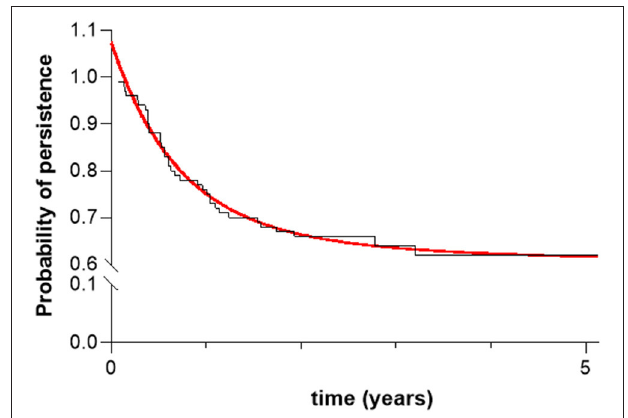
FIGURE 1 | Survival curve of secukinumab in the entire population. Red line represents the fit of the Kaplan-Meier survival curve to the exponential two-phase decay equation model ( R 2 =